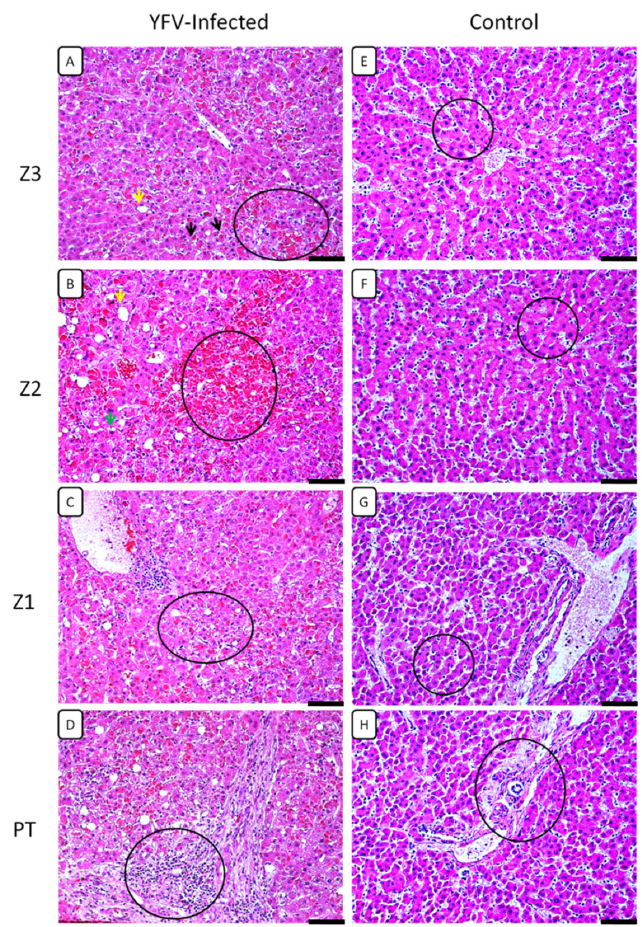
Figure 1. Histopathological analysis in the zones Z3, Z2, and Z1 and PT in the hepatic parenchyma of patients with fatal YF and normal controls. ( A ) Macrovesicular steatosis (yellow arrow), Councilman bodies (black arrow), coagulative necrosis (circle). ( B ) Macrovesicular steatosis (yellow arrow), microve ‐ sicular steatosis (green arrow), intense haemorrhagic necrosis (circle). ( C ) Mild coagulative necrosis and steatosis (circle). ( D ) Presence of inflammatory infiltrates in the PT (circle). ( E – H ) Preservation of the he ‐ patic parenchyma (Z3, Z2, Z1, and PT) in the control cases (circles). Magnification: 400× (scale bar, 20 μ m). Z3: Pericentral zone; Z2: Midzonal zone; Z1: Periportal zone; PT: Portal tract. (Patient